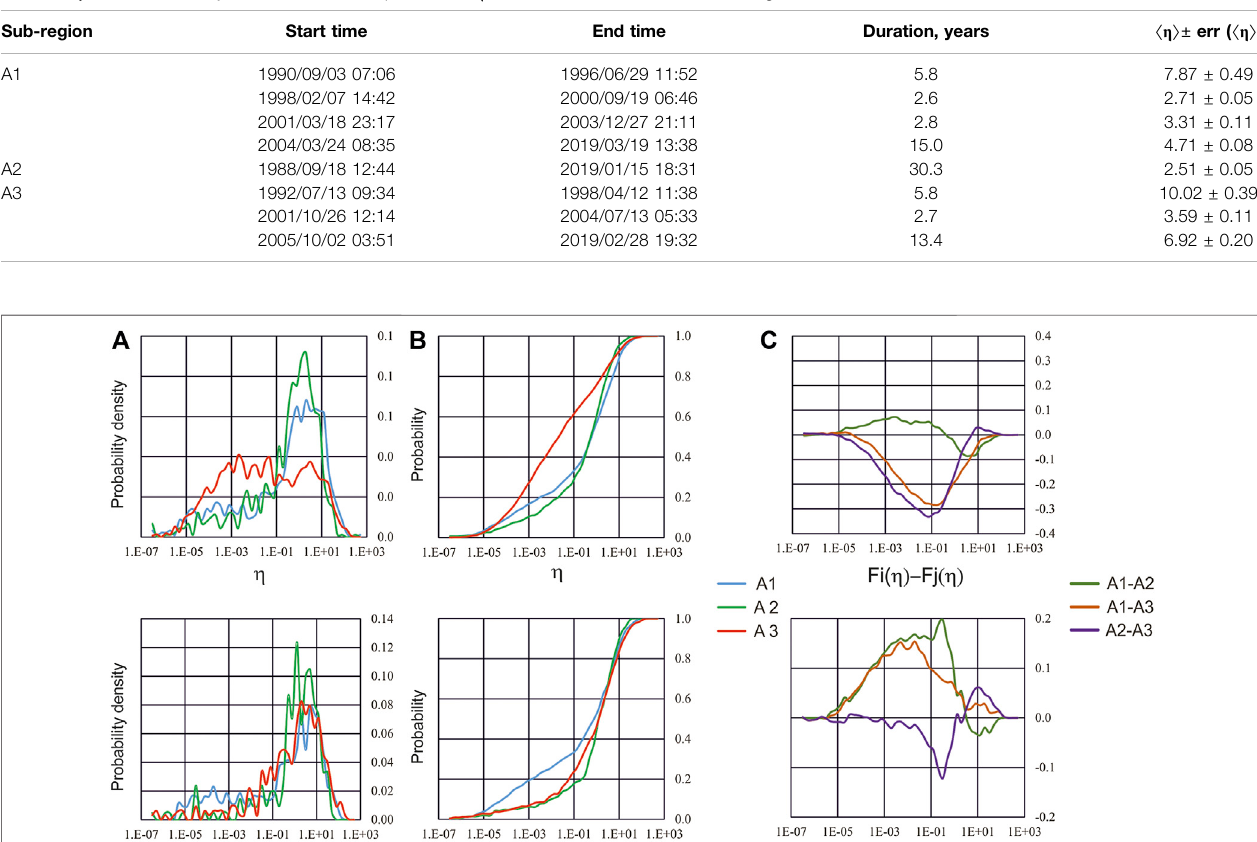
Frontiers in Earth Science |